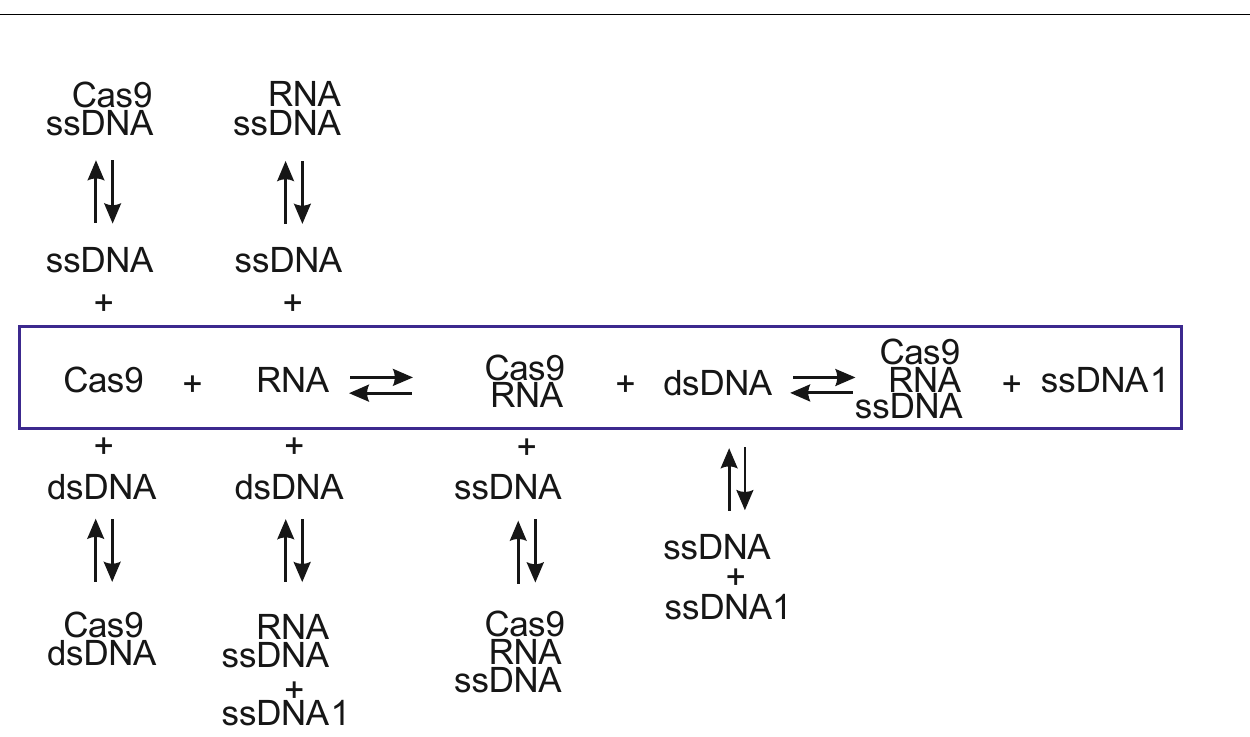
Figure 1. The schematic diagram of the possible interactions during formation of the Cas9– RNA/ssDNA complex.